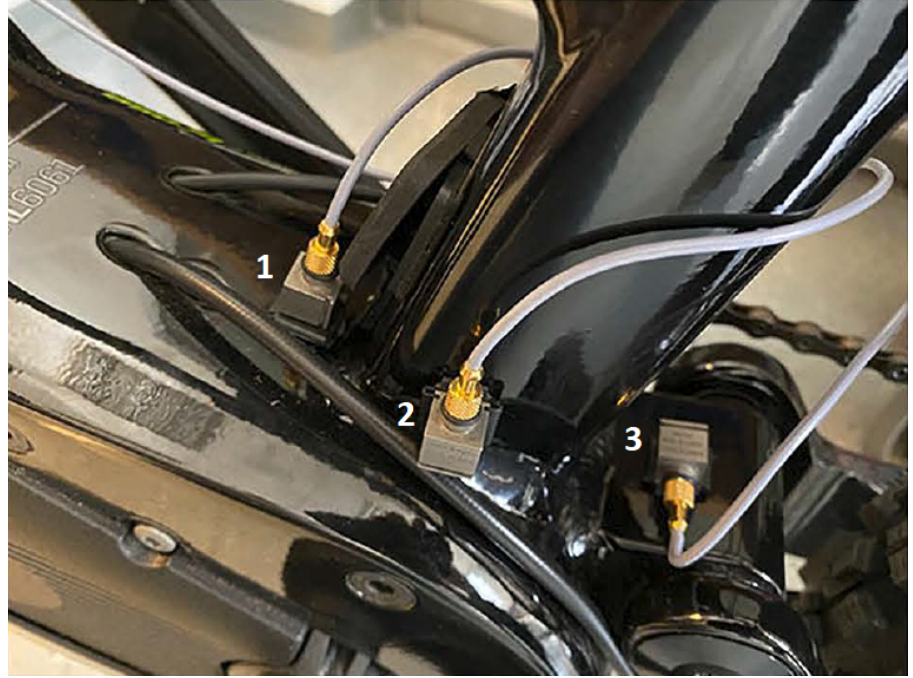
Figure 2. Accelerometer positions on bicycle frame: 1—longitudinal direction (x); 2—lateral direction (y); 3—vertical direction (z).